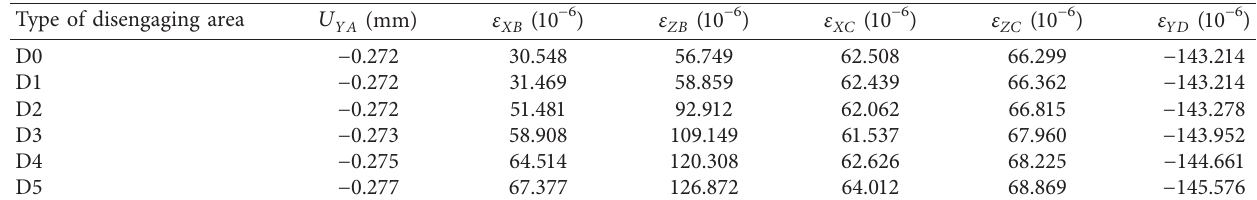
Table 4: Responses with interlayer bonding failure at the room temperature.